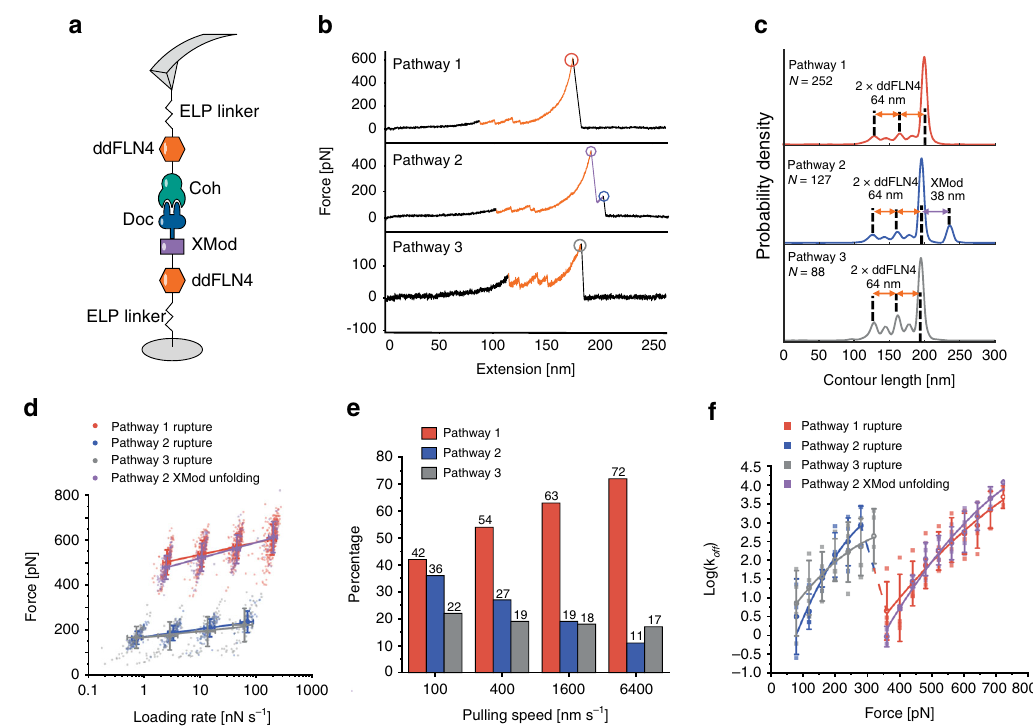
Fig. 2 XMod-Doc:Coh unbinds along three pathways under mechanical load. a Experimental con fi guration with Coh-ddFLN4-ELP immobilized on the AFM tip and ELP-ddFLN4-XMod-Doc immobilized on the surface. Immobilization was site-speci fi c and covalent through a terminal ybbR tag on the ELP. b Three different classes of force curves were repeatedly observed, corresponding to different pathways. In pathway 1 (P1), the complex ruptured at high force (500 – 600 pN, red circle) with the XMod remaining folded. In pathway 2 (P2), XMod unfolded (purple circle) followed by a low force rupture of the complex (blue circle). In pathway 3 (P3), the complex ruptured at low force rupture (gray circle) with the XMod remaining folded. Unfolding of the two ddFLN4 fi ngerprint domains (orange) was used to identify single-molecule traces. c Combined contour length histograms for each unbinding pathway. Force-extension traces were transformed using a freely rotating chain elasticity model and aligned using cross-correlation analysis. Histograms show contour length increments resulting from unfolding of 2× ddFLN4 and XMod. d Rupture force vs. loading rate plot showing fi nal XMod-Doc:Coh complex rupture events obtained from the three pathways, as well as XMod unfolding events observed in P2. Error bars represent the standard deviation of rupture forces and loading rate ( n = 74-317). Lines show linear Bell – Evans fi ts of the most probable rupture/unfolding force vs. logarithm of loading rate to obtain Δ x ‡ and k Δ x ‡ and k 0 (Eq. (2)). Fitted 0 values are listed in Table 1. e Percentages of the three pathways in all rupture events at different pulling speeds. f Kinetic off-rate ( k off ) vs. force for complex rupture and XMod unfolding events. Force-dependent off-rates calculated using the histogram transformation method (Eq. (3)) were plotted against force (shown in boxes). The average off-rates of four different pulling speeds were shown in open circles and fi tted to the analytical expression (Eq. (5)) with υ = 0.5. Error bars represent the standard deviation of off-rate ( n = 2 – 4). The fi tted Δ x ‡ , Δ G ‡ , and k 0 values are listed in Table